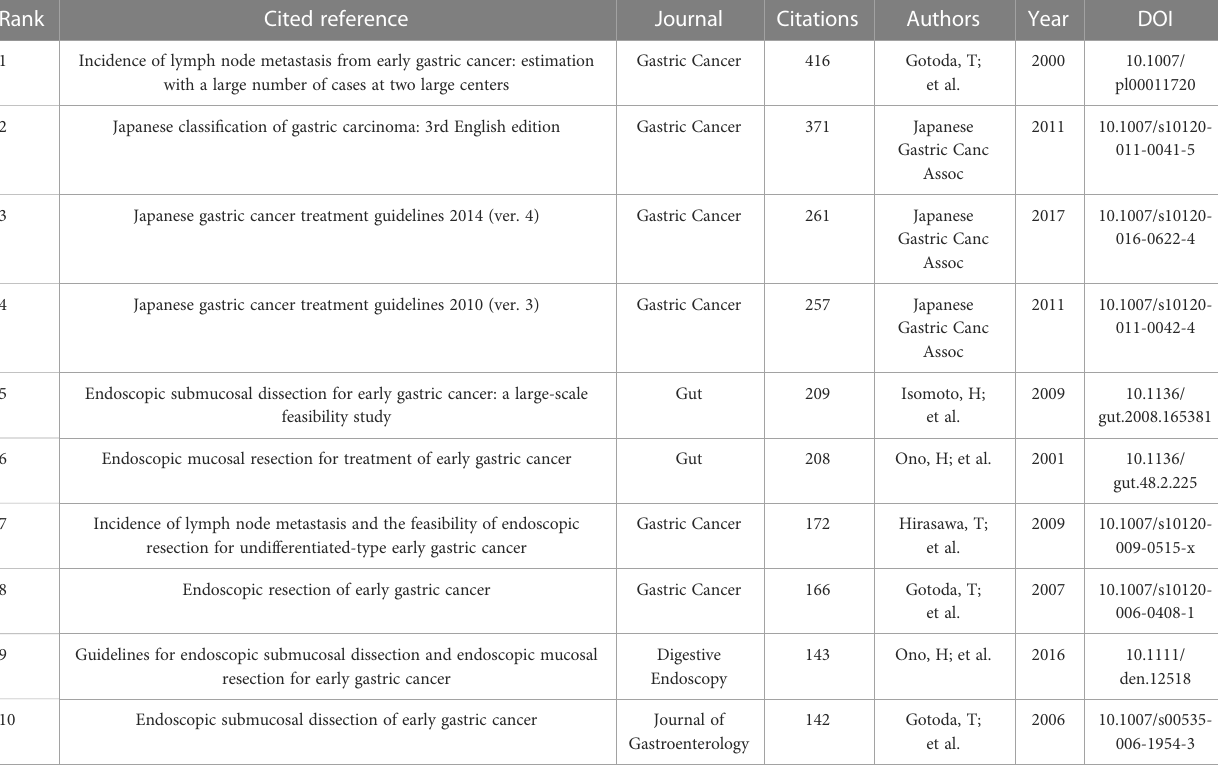
TABLE 6 Top 10 co-cited references related to endoscopic application in early gastric cancer.